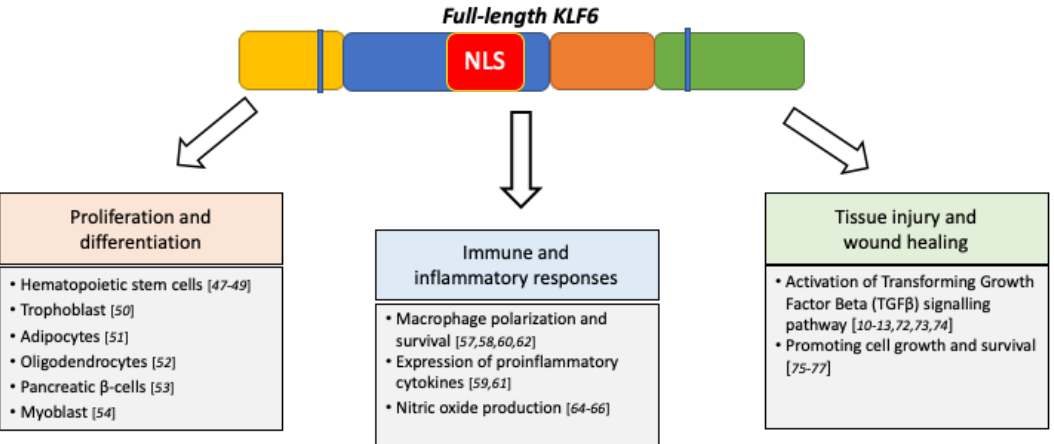
Figure 5. Diagram summarising the roles of KLF6 in normal physiological processes.